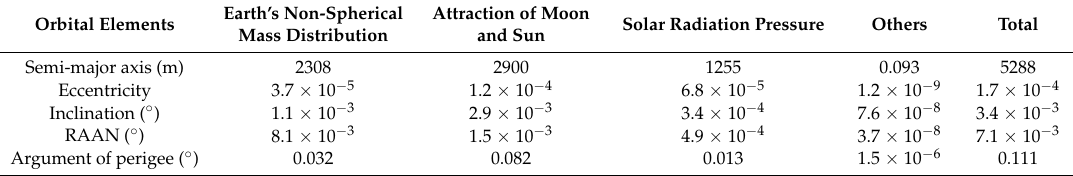
Table 7. Ranges of the orbital elements variations caused by the simulated short periodical perturbations.